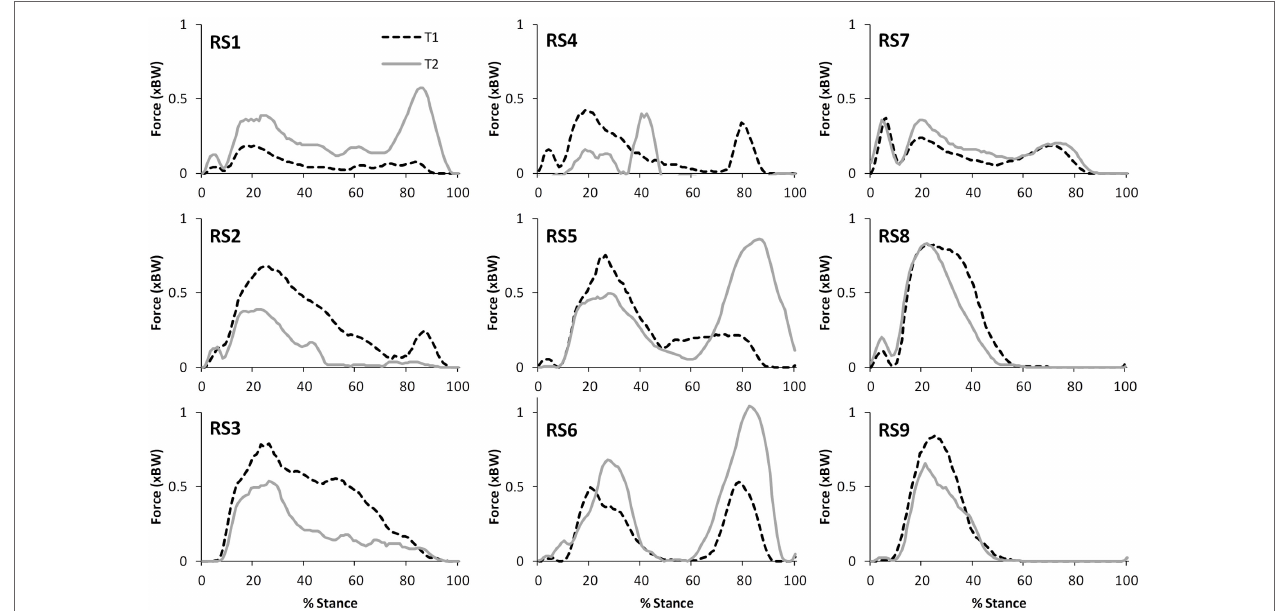
FIGURE 6 | A comparison of the subject specific variation (between test sessions 1 and 2) in predictions of hamstring forces during stair ascent.